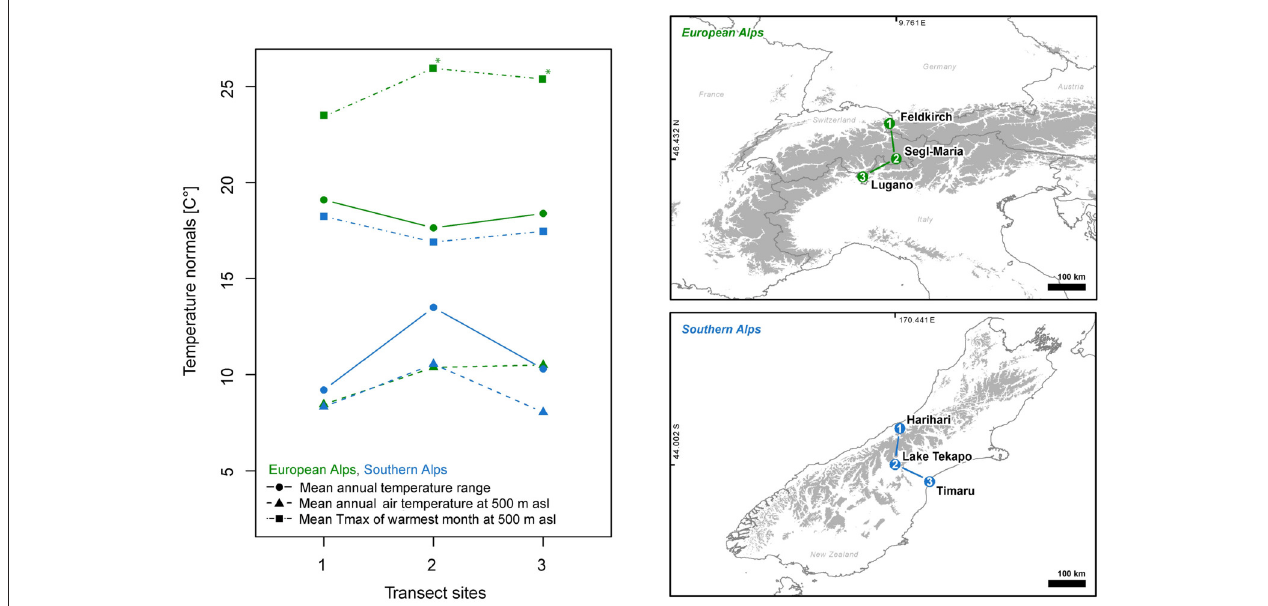
FIGURE 2 | Comparison of mean annual temperature range (i.e, difference between the mean air temperatures of the warmest and coldest month), mean annual air temperature extrapolated to 500m asl (using the standard environmental lapse rate of 6.5 ◦ km − 1 , Barry, 2008), and mean daily maximum temperature (Tmax) of the warmest month extrapolated to 500m asl for three climate stations in the New Zealand Southern Alps and three climate stations in the European Alps. New Zealand stations: Harihari, ID 4044, 43.144S 170.553 E, 45m asl; Lake Tekapo, ID 4970, 44.002S 170.441 E, 762m asl; Timaru, ID 5095, 44.412 S 171.254 N, 17m asl; NZ data source: NIWA, 2010; European stations: Feldkirch, 47.267 N 9.6 E, 439m asl, source: ZAMG, 2002; Segl-Maria, ID 24, 46.43 N 9.76 E, 1804m asl; Lugano, ID 47, 46.00 N 8.96 E, 273m asl, Swiss data source: MeteoSchweiz, 2014. Temperature normals are derived from homogenized data series for the standard climate period 1971–2000, with the exception of mean maximum temperatures for the Swiss stations Segl-Maria and Lugano (marked with * ), which were only available in homogenized form for the climate period 1981–2010. Maps: Elevation data (area > 1000m asl): WorldClim’s elevation dataset (Hijmans et al., 2005), country boundaries: Global Administrative Areas database V2.8 (GADM,